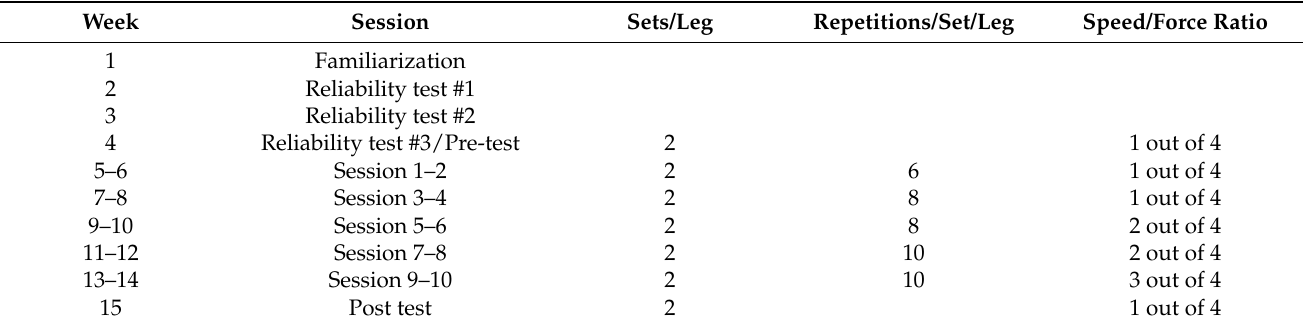
Table 1. Familiarization, lateral squat eccentric overload training program, and testing